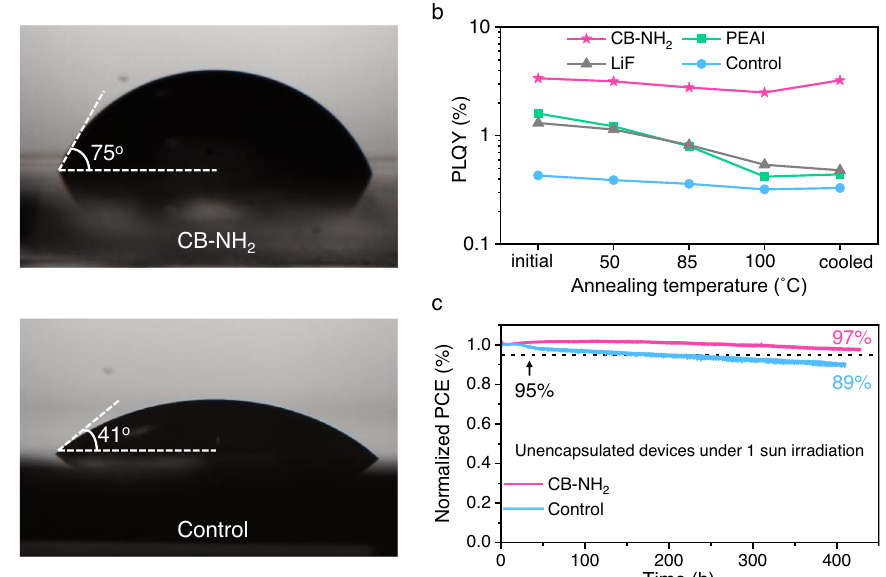
Fig. 3 | Stability evaluation. a Contact angle measurement using water for a neat reference and a CB-NH 2 -treated perovskite. For the CB-NH 2 treated samples, the contact angle with water is larger. b Passivation stability of CB-NH 2 , PEAI, LiF on